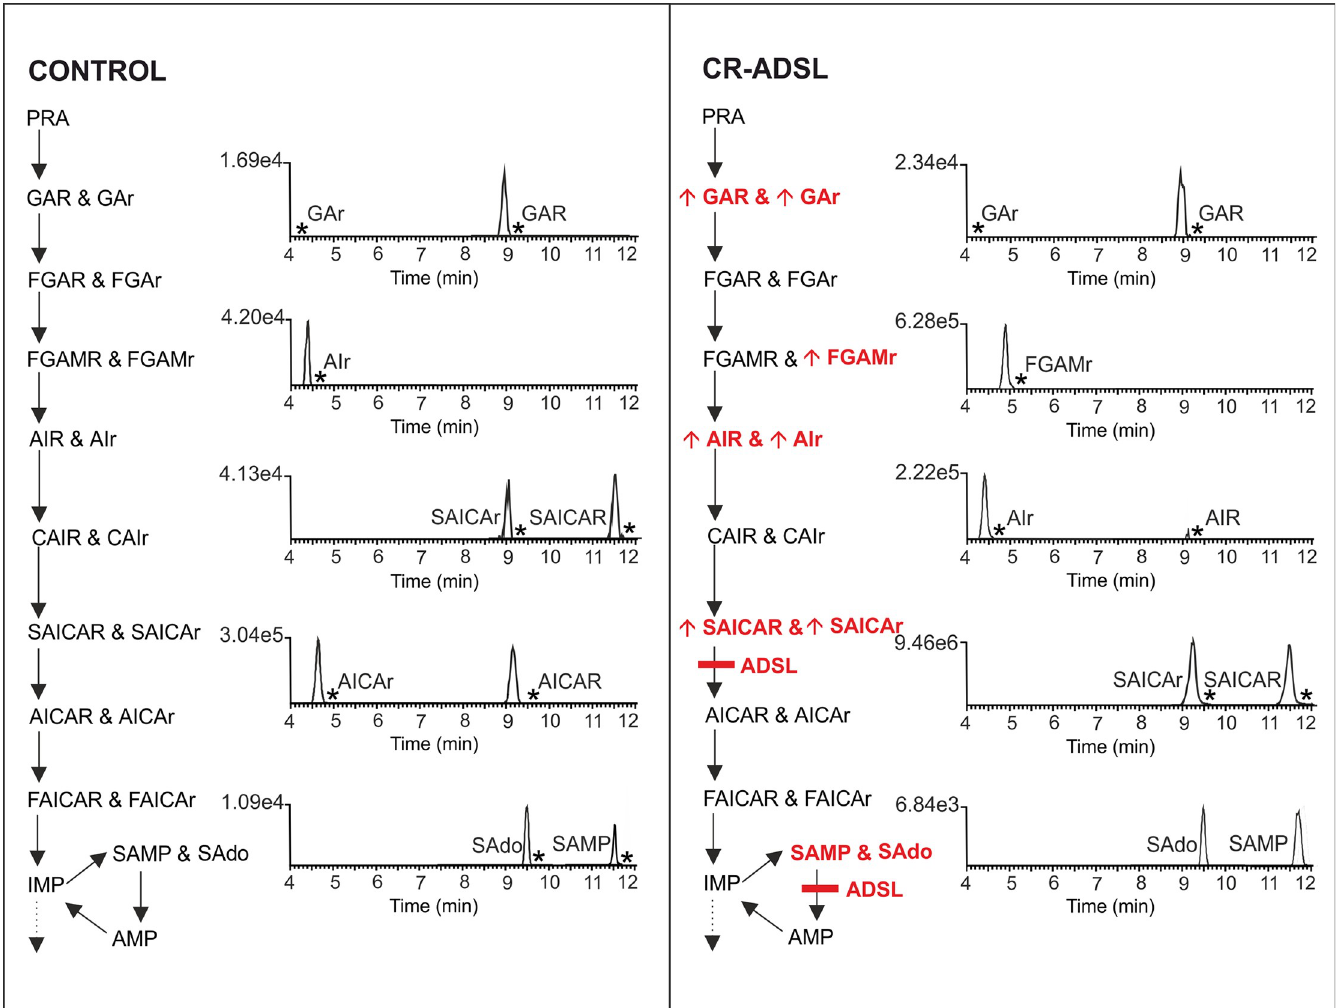
Fig 6. Ribotides and ribosides detected in cell lysates of ADSL-deficient and control HeLa cells. The deficient cell line is graphically represented by a PDNS pathway with an enzyme block marked by a red rectangle. Accumulating metabolites are marked with red bold letters with an arrow. Cell lines were measured in hexaplicate, and the value of the unlabeled peak intensity given above the baseline represents the average of a particular metabolite. Chromatographic peaks of metabolites that were detected also in labeled form are shown as an asterisk. Note: The ionization efficiency of ribotides and ribosides is substantially different, so the responses of these compounds are not directly